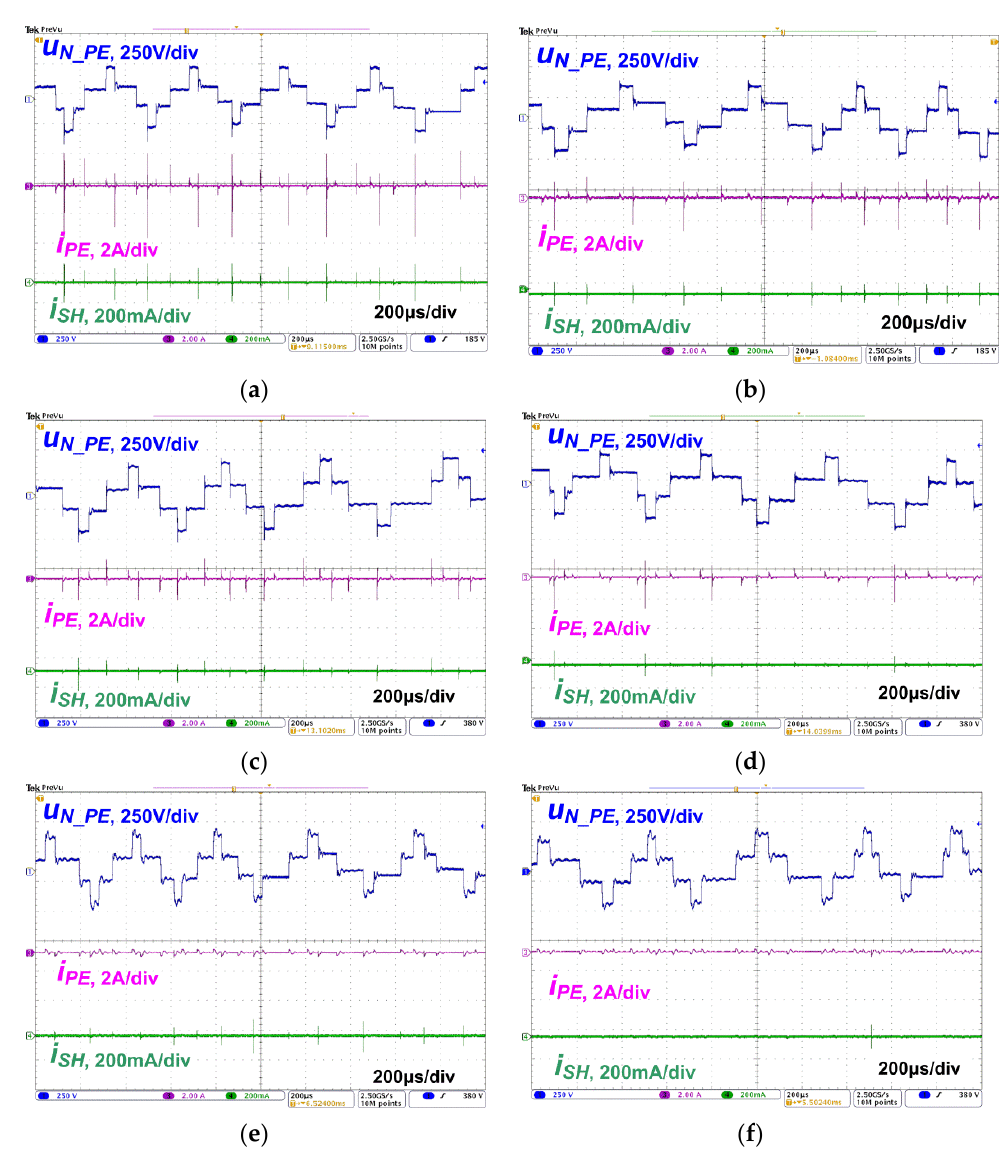
Figure 28. Experimental waveforms of CM voltage u N_PE , leakage current i PE and shaft-grounding brush current i SH measured in a configuration with a 1 m cable for: ( a ) inverter; ( b ) motor choke; ( c ) du/dt choke; ( d ) sine-wave filter; ( e ) CM choke; ( f ) CM choke with sine-wave filter.